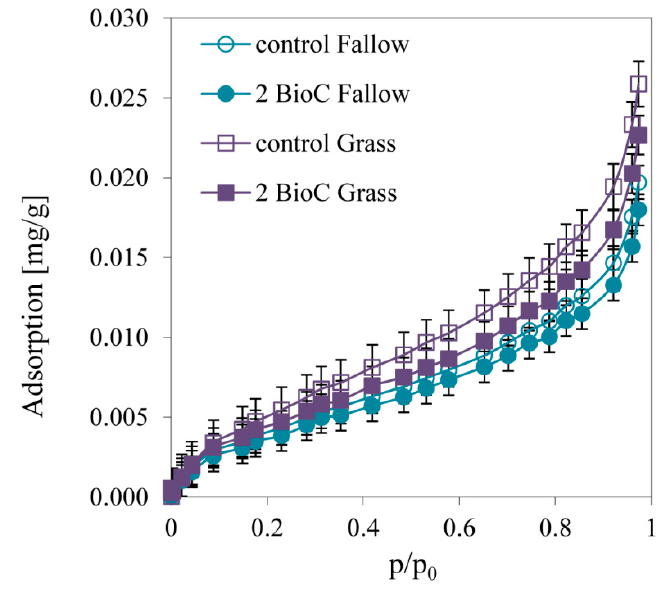
Figure 3. Selected water vapor adsorption isotherms for soil samples collected from fallow and grassland amended with BioC (0 and 2 kg · m − 2 ) at first term of field experiment. Average values from three replicates in each term, ± standard deviation.